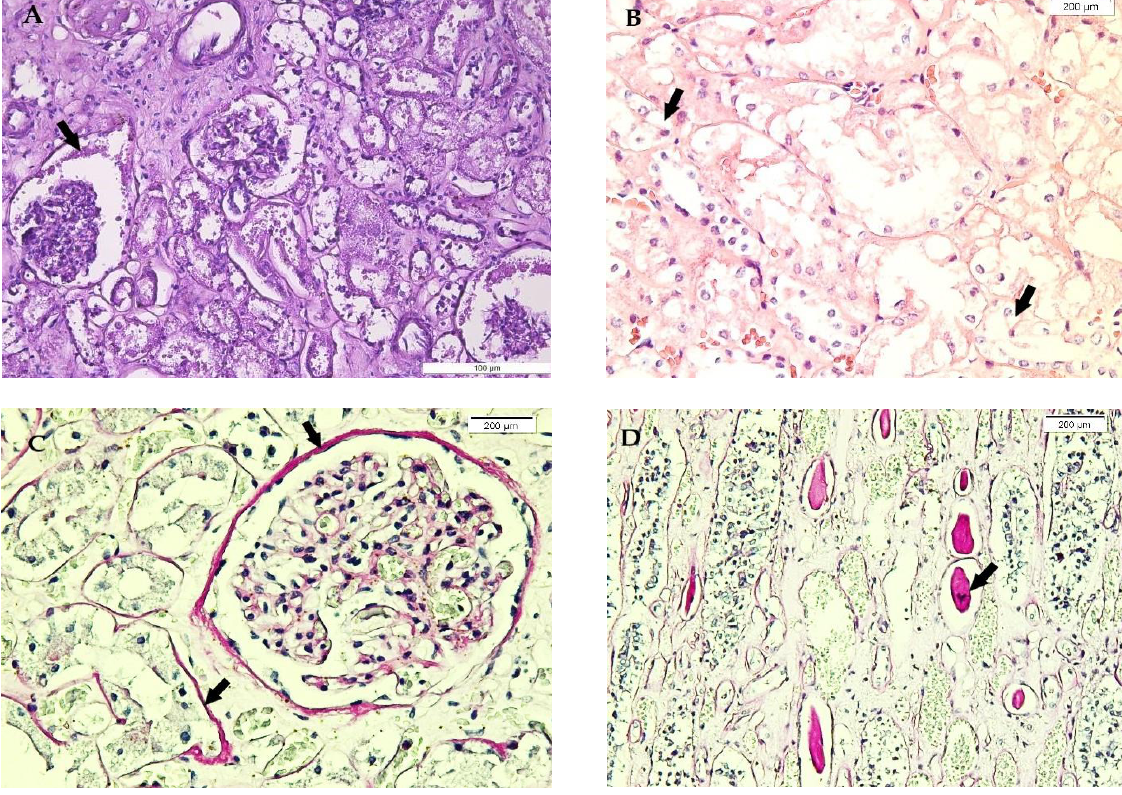
Figure 3. Renal microscopic features in hypothermia cases. ( A ) Focal glomerulosclerosis, interstitial oedema, basement membranes thickening, and amorphous material in Bowman’s space, H&E